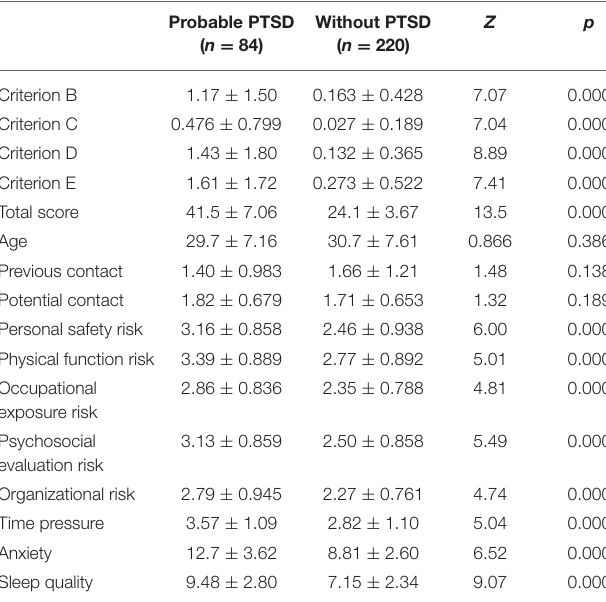
TABLE 2 | Differences in measured variables between medical staff with or without probable